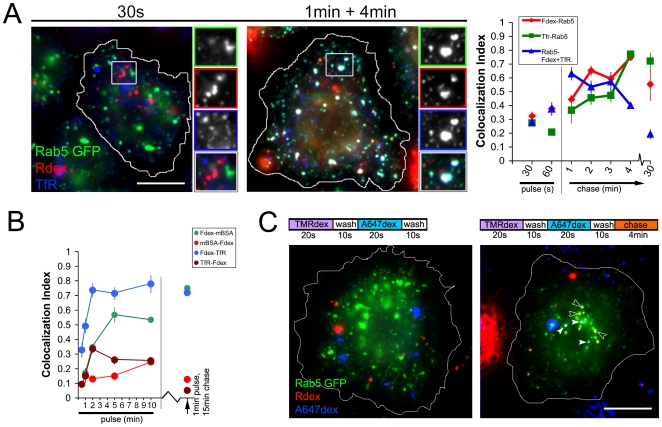
Fluid phase and TfR pathways intersect in Rab5-positive compartments and subsequently follow expected fates.(A) TMR-dextran (Rdex) was co-pulsed with A647Tf (TfR) in cells expressing Rab5 GFP (Rab5 GFP) for 30 s (left pane) or the pulse was chased for 4 min in complete medium (right pane). Graph shows quantified colocalization indices over different pulse (30 s or 60 s) and pulse and chase times (1 min pulse and 1, 2, 3 or 4 min chase; and a 3 min pulse and 30 min chase) of: Tf-labeled endosomes co-localized with Rab5 GFP (blue symbols and line); Rdex endosomes with Rab5 GFP (red symbols and line); and Rab5 GFP-labelled endosomes that contained both Rdex and Tf (green symbols and line). Data points represent mean±s.e.m pooled from 2 independent experiments with at least 20 cells for each point. (B) Time course of mixing of Fdex, mBSA and TfR probes in S2R+ cells. Colocalization values for different probes and pulse times (0.5 min, 1 min, 2 min, 5 min and 10 min; or a 15 min chase following a 1 min pulse) were obtained as described earlier (Figure 1A). The fraction of TfR or mBSA endosomes that also contain Fdex is relatively low at all time points [TfR-Fdex (brown symbols and line) and mBSA-Fdex (red symbols and line), respectively]). Conversely, the fraction of Fdex endosomes that contain TfR (Fdex-TfR; blue symbols and line) or mBSA (Fdex-mBSA; green symbols and line) is initially low, and increases with longer pulse times. (C) S2R+ cells expressing Rab5 GFP were pulsed with Rdex, washed and then pulsed with A647dex to examine homotypic fusion of newly formed fluid endosomes (see schema at the top of image). Rab5 GFP was not found on endosomes labeled with either the first or the second short pulse of dextran (left panel). When the two staggered pulses were chased for 4 min (right panel), endosomes containing the first pulse acquired Rab5 GFP (empty arrowheads) and a fraction of these also contained the second pulse (filled arrowheads). There was little or no mixing between the two pulses outside Rab5 GFP labeled structures. Bars in A, C = 5 µm, insets magnified 2x.